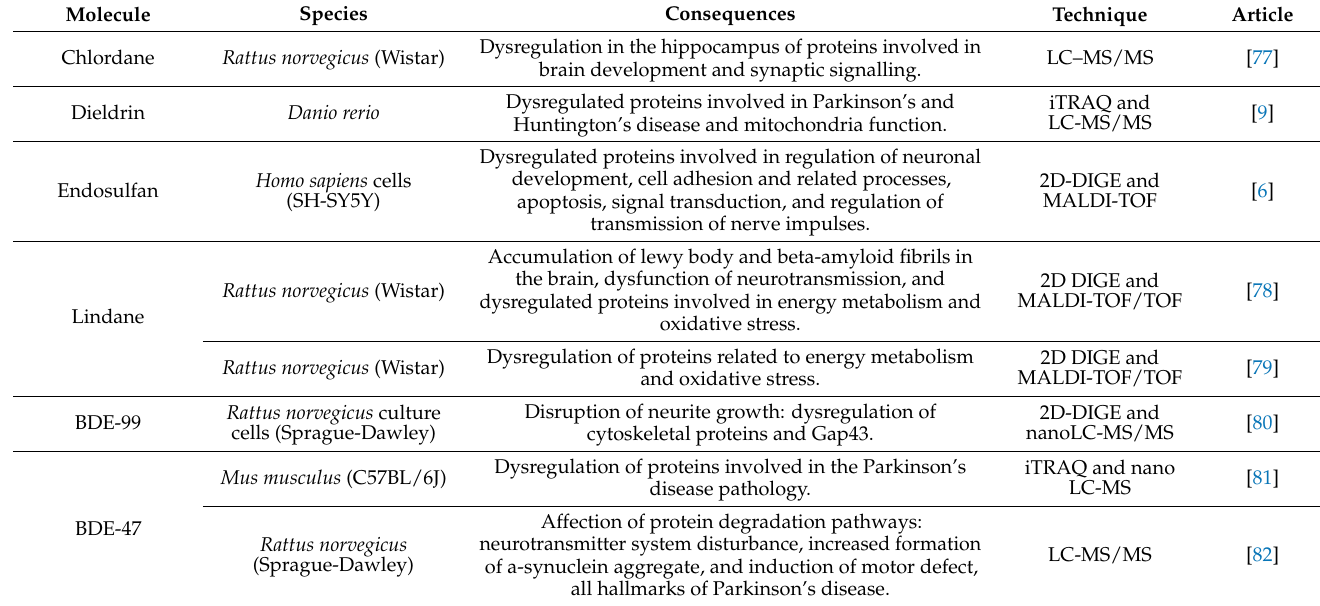
Table 4. Articles describing POP-induced